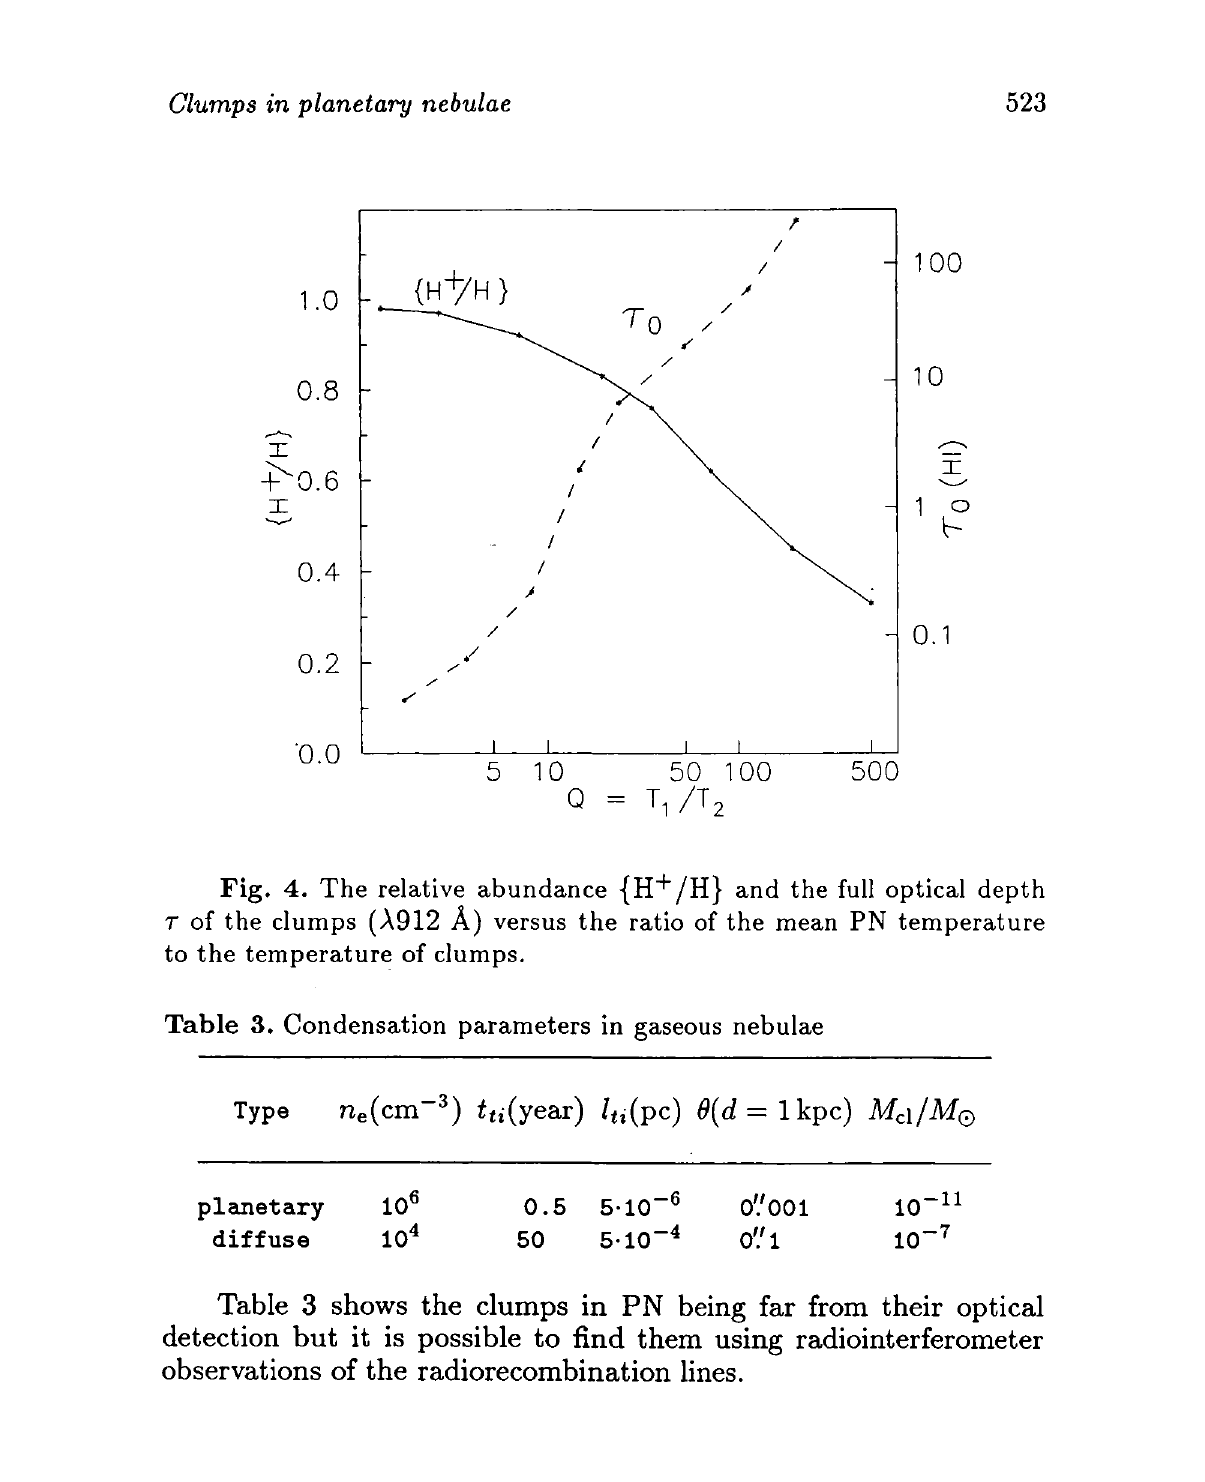
Fig. 4. The relative abundance { H ^ / H} and the full optical depth r of the clumps (A912 A) versus the ratio of the mean PN temperature to the temperature of clumps. Table 3. Condensation parameters in gaseous nebulae